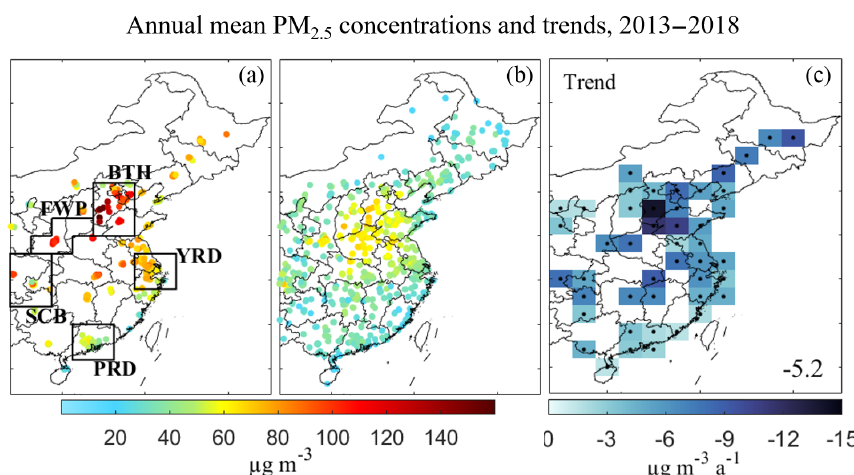
Figure 1. Annual mean PM 2 . 5 concentrations in China from the CNEMC network. Panels (a) and (b) show values for 2013 and 2018 for sites with more than 70% data coverage for the corresponding year. Panel (c) shows the ordinary linear regression trends on a 2 ◦ × 2.5 ◦ grid for sites with more than 70% data coverage for each of the 6 years from 2013 to 2018. The trends are based on the time series of 10d mean anomalies, as described in the text. Polygons in (a) define the four target regions of the Clean Air Action (Beijing–Tianjin–Hebei – BTH: 35– 41 ◦ N, 113.75–118.75 ◦ E; Yangtze River Delta – YRD: 29–33 ◦ N, 118.75–123 ◦ E; Pearl River Delta – PRD: 21–25 ◦ N, 111.25–116.25 ◦ E; and Fenwei Plain – FWP: 33–35 ◦ N, 106.25–111.25 ◦ E, and 35–37 ◦ N, 108.75–113.75 ◦ E), to which we add Sichuan Basin (SCB; 27–33 ◦ N, 103.75–108.75 ◦ E). Number inset in panel (c) is the trend in mean PM 2 . 5 over the study region (21–41 ◦ N, 103.75–123 ◦ E). Dots in panel (c) indicate grid squares with significant trends ( p < 0 .